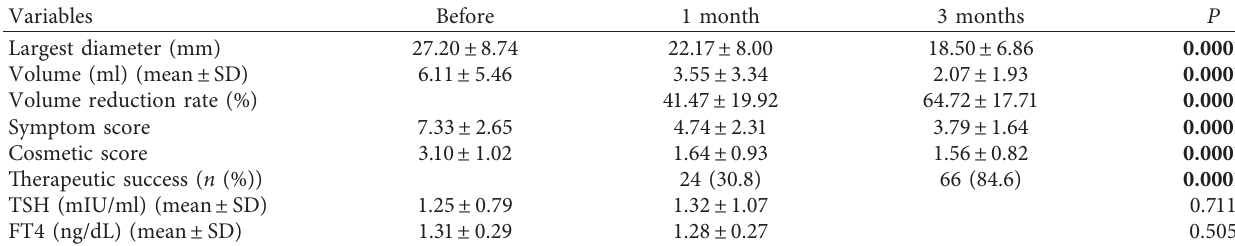
Table 3: Outcomes for 78 benign thyroid nodules after RF ablation Variables Before